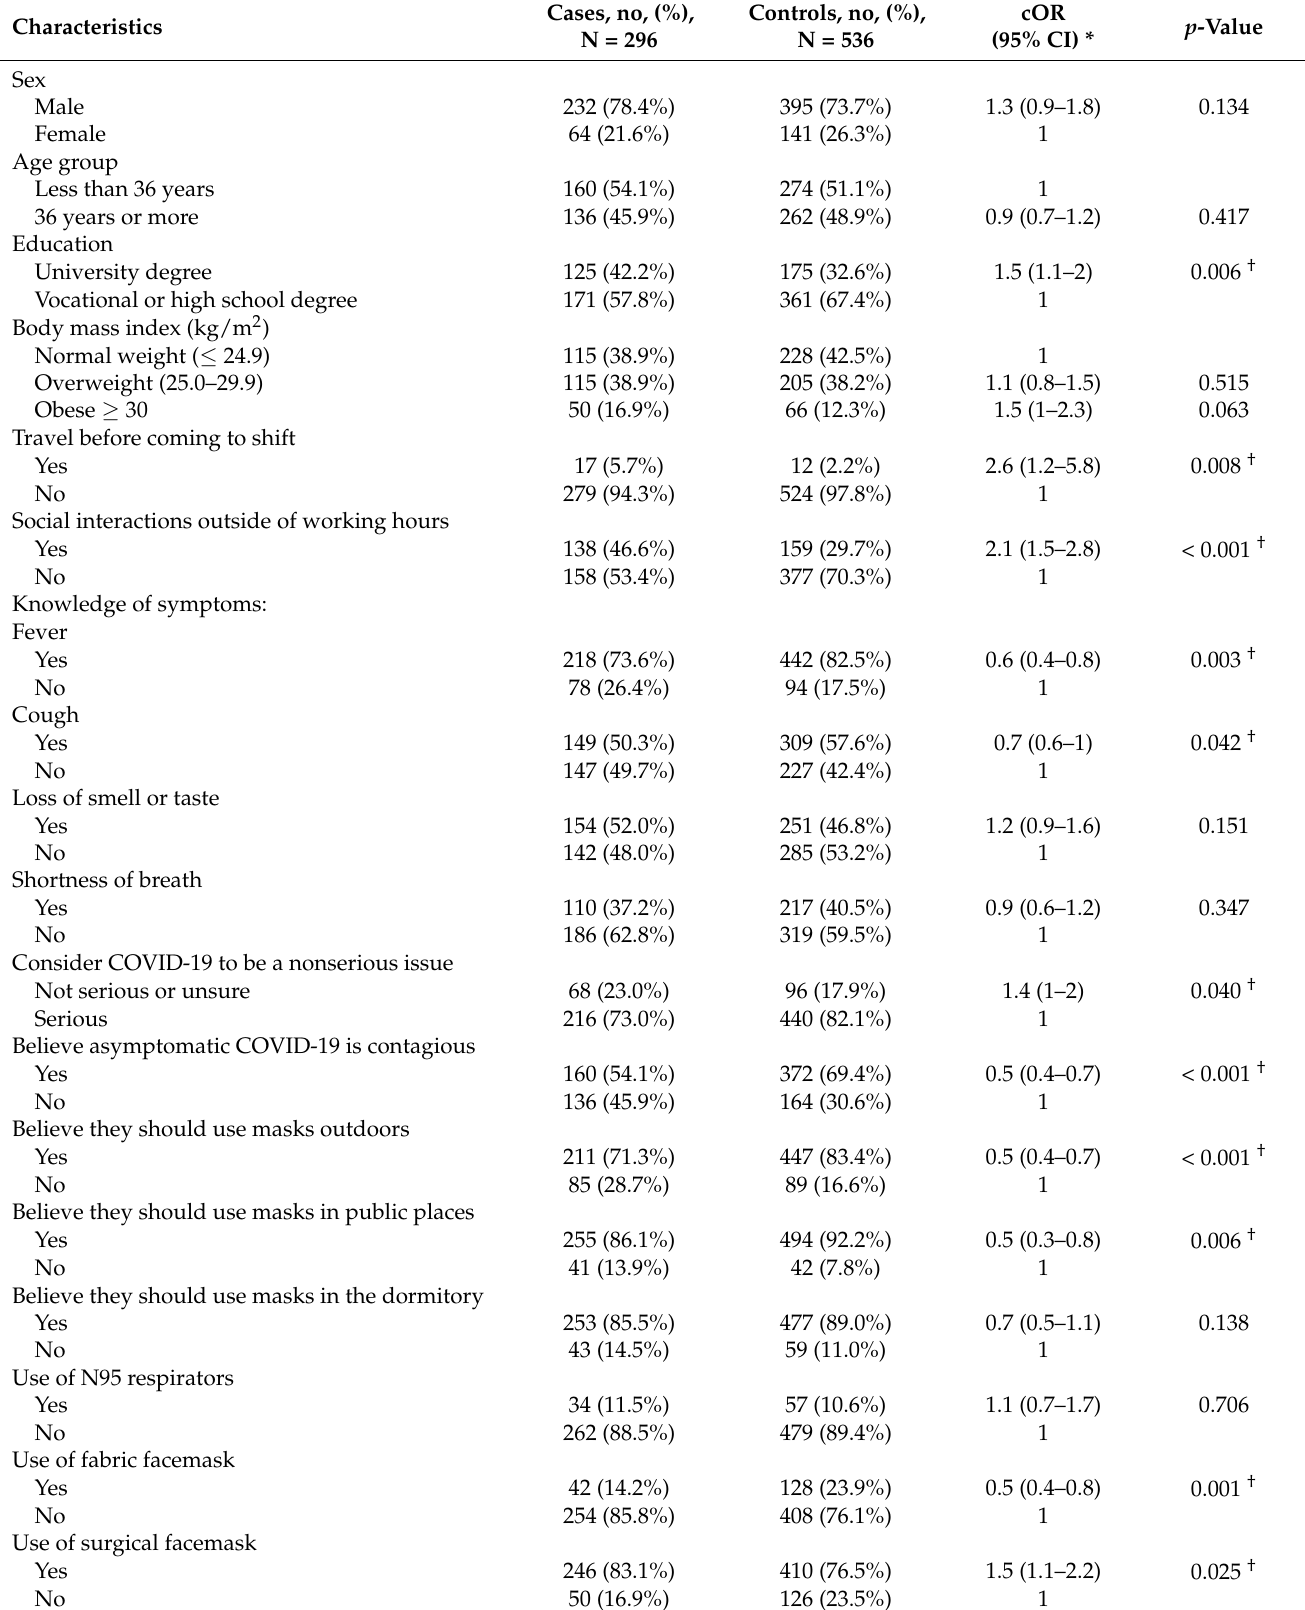
Table 2. Bivariate model of the individual risk factors associated with novel coronavirus disease among the employees of Tengizchevroil, Kazakhstan during June–September